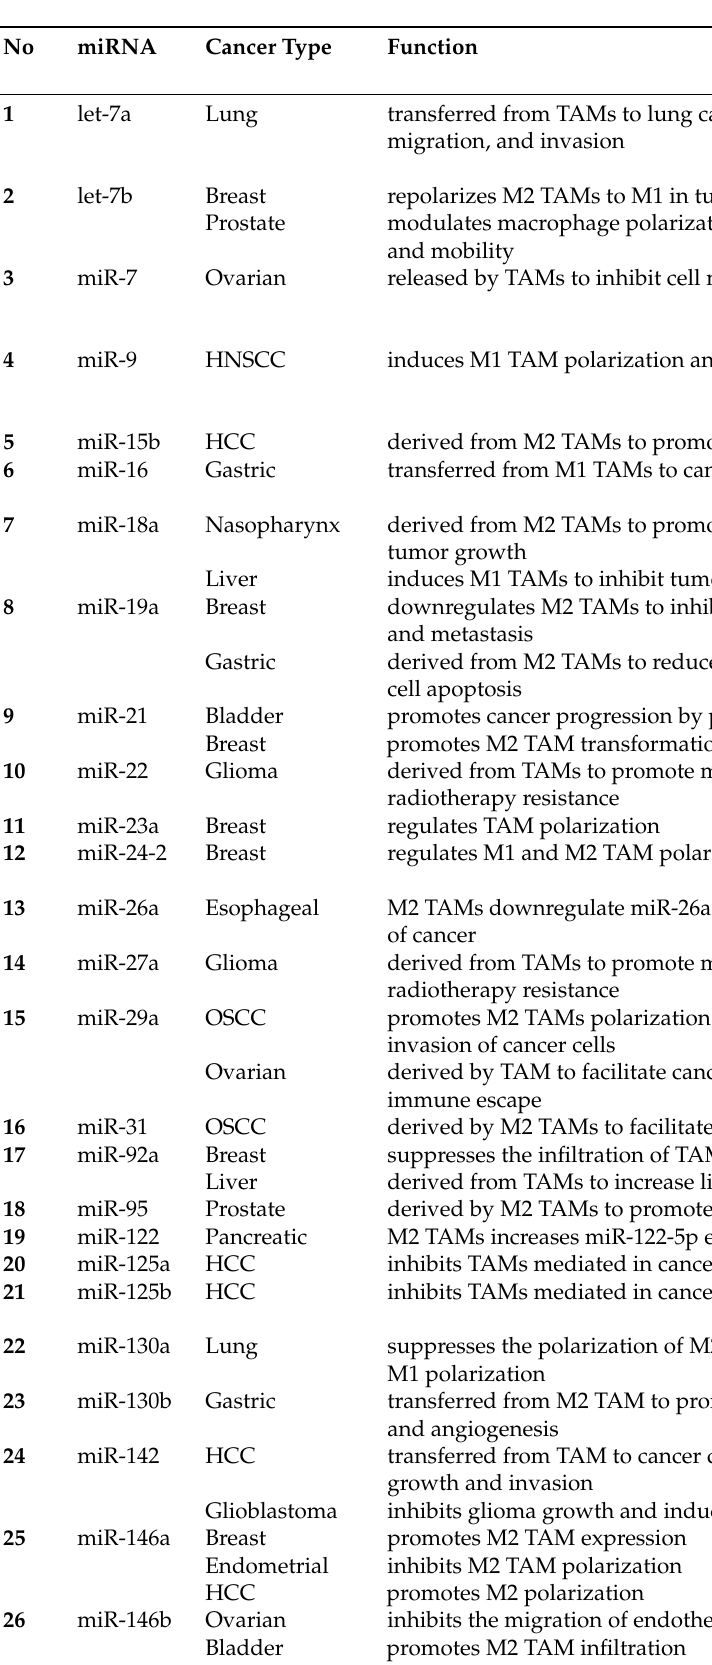
Table 1. List of TAM-related miRNAs from various